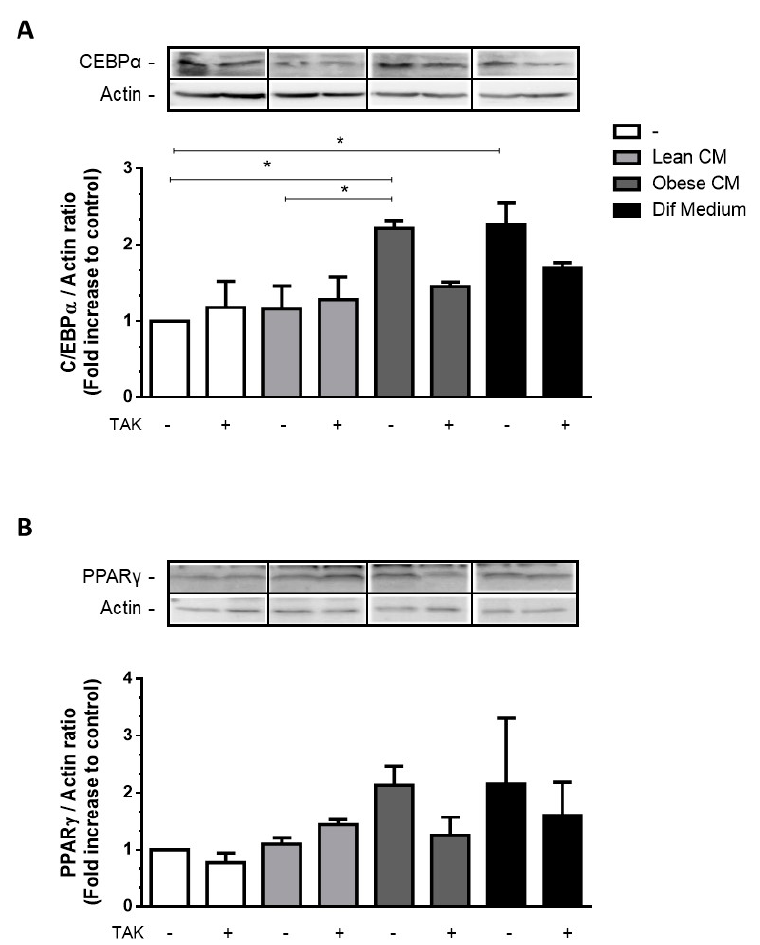
Figure 4. 3T3-L1 cells were left untreated or were pre-incubated with TAK-242 (TAK) 1 µ M for 15 min, at 37 ◦ C / 5% CO 2 . After pre-treatment, 3T3-L1 cells were treated or not with Lean Conditioned Medium (CM), Obese Conditioned Medium, or di ff erentiation mix for 48 h. Thirty µ g of proteins from cell lysates were subjected to Western blotting for C / EBP α ( A ) and PPAR γ ( B ). Results are representative of three independent experiments. Data are expressed as means ± SEM. * Represents p < 0.05.